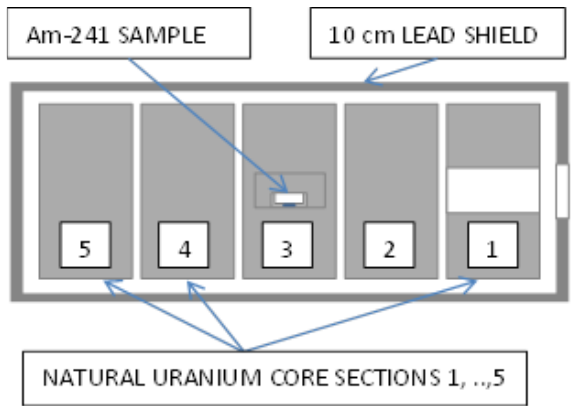
Figure 2. QUINTA setup vertical-axial cross section